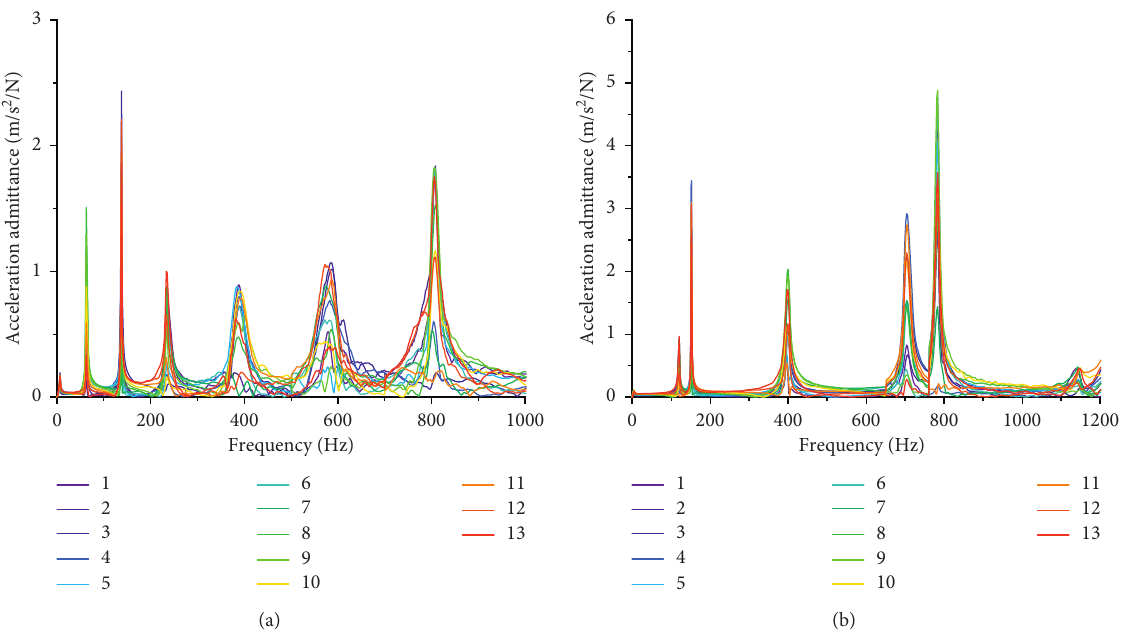
Figure 6: Frequency response functions of modal tests on carbon strip: (a) vertical and (b) transverse modal frequencies.